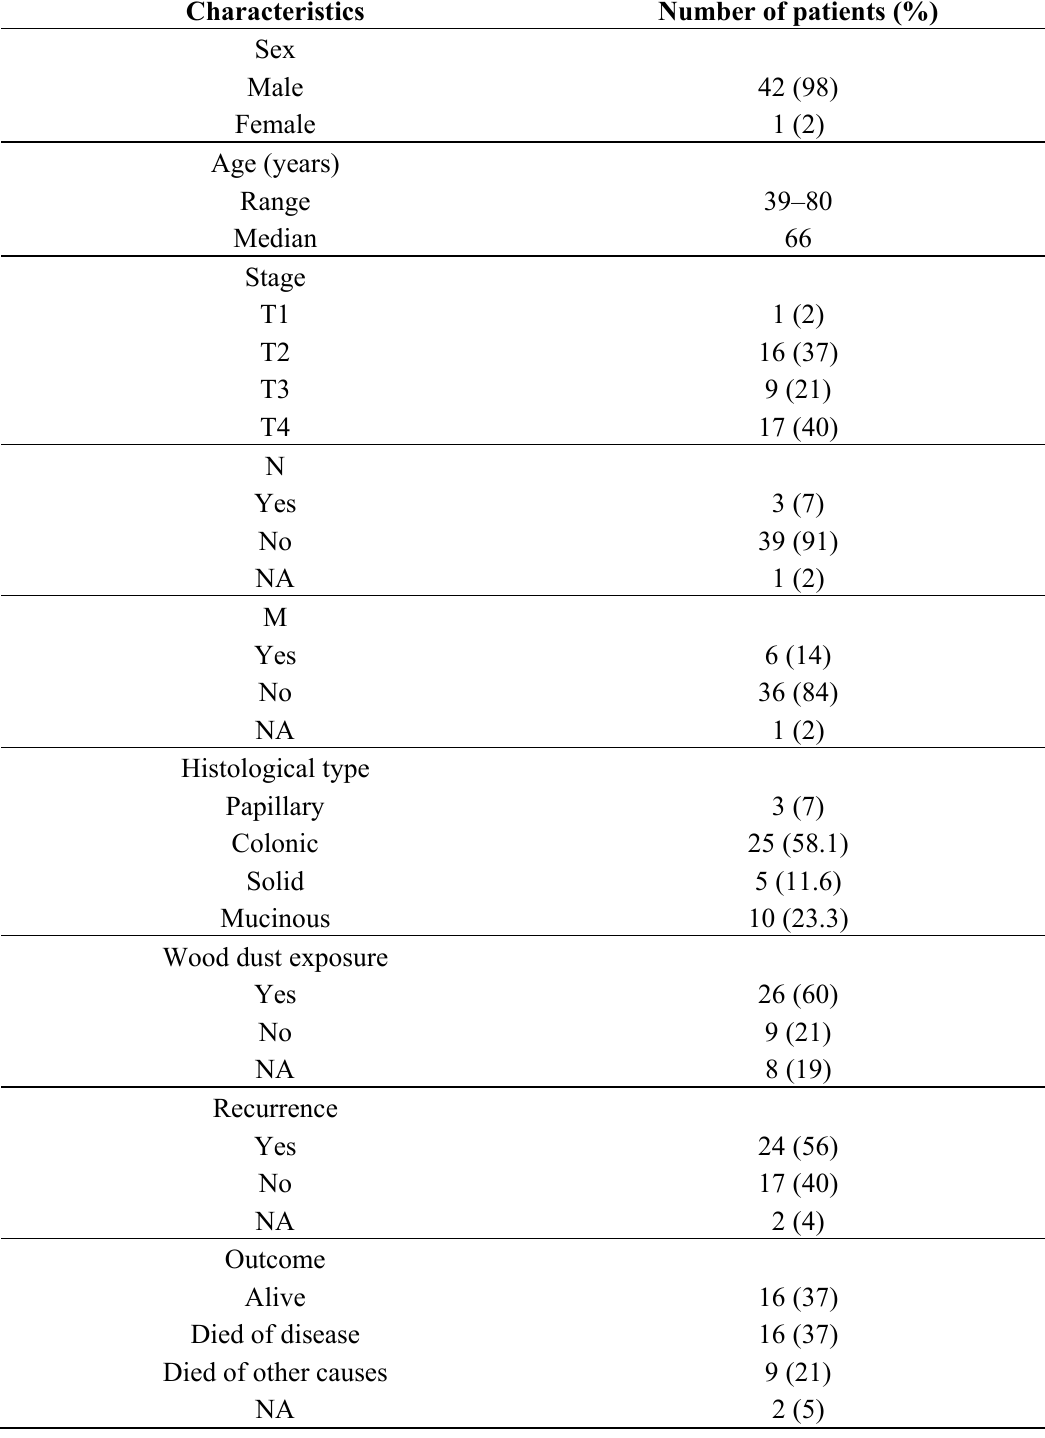
Table 1. Clinical features of 43 patients with intestinal-type adenocarcinoma